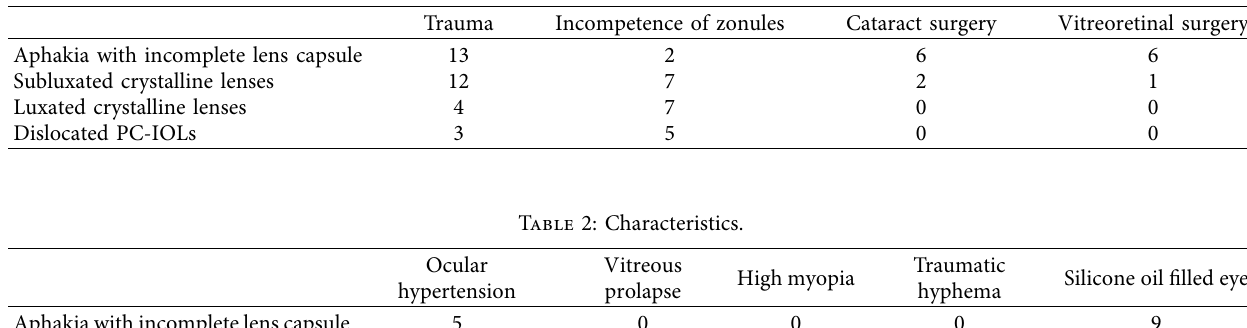
Table 1: Indications for surgery.